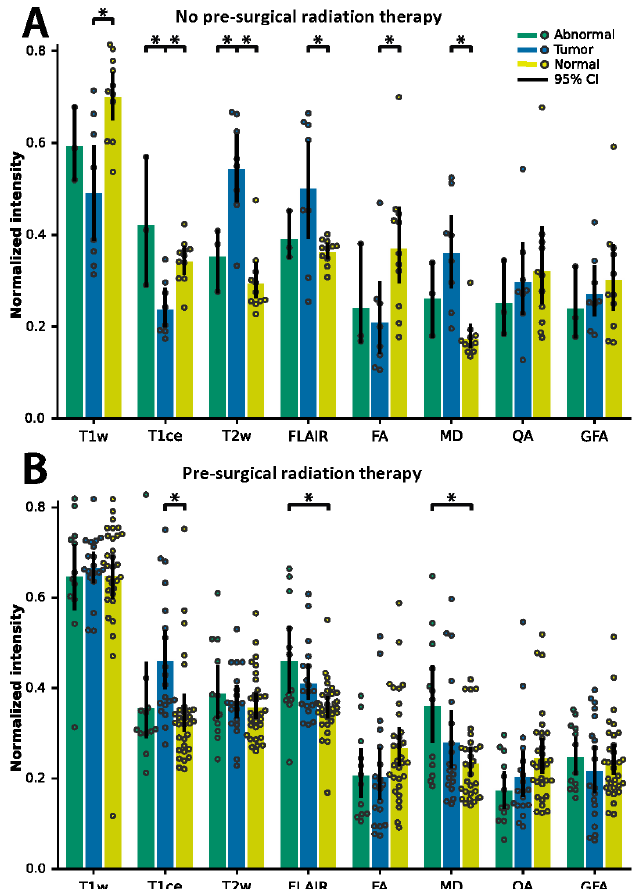
Figure 2. Average ROI normalized image intensity for biopsies classified as Abnormal (green) and Tumor (blue). Contralaterally mirrored ROI locations classified as Normal (yellow). Data separated depending on chemoradiation therapy strategy prior to re-resection: ( A ) patients with adjuvant radiation therapy and ( B ) patients without adjuvant radiation therapy. Error bars show 95% confidence intervals. Asterisks indicate significance determined using Tukey’s post-hoc test, p < 0.05.